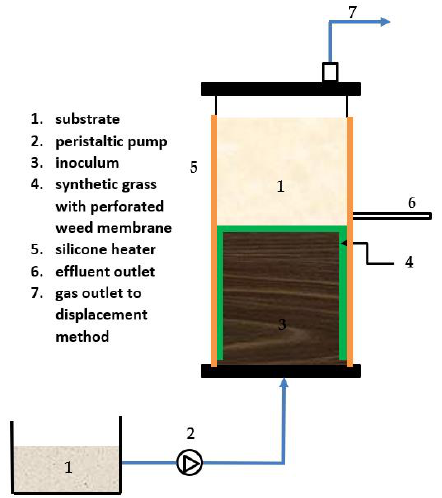
Figure 2. Schematic diagram of continuous stirred tank reactor (CSTR).